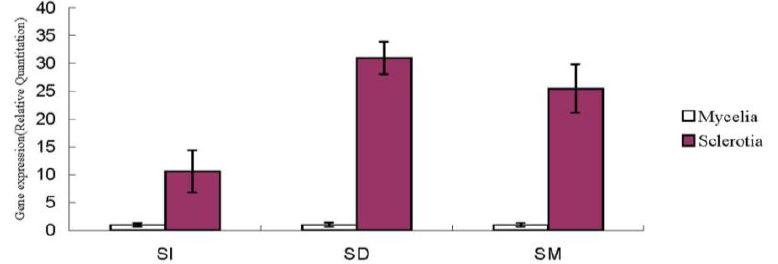
Figure 5. Nox gene expression during P. umbellatus sclerotial formation. The relative expression of Nox gene in the mycelia and the sclerotia was detected during the different stages of sclerotial formation (SI, SD and SM). Each symbol and vertical bar represent the mean values ± SD ( n = 3).